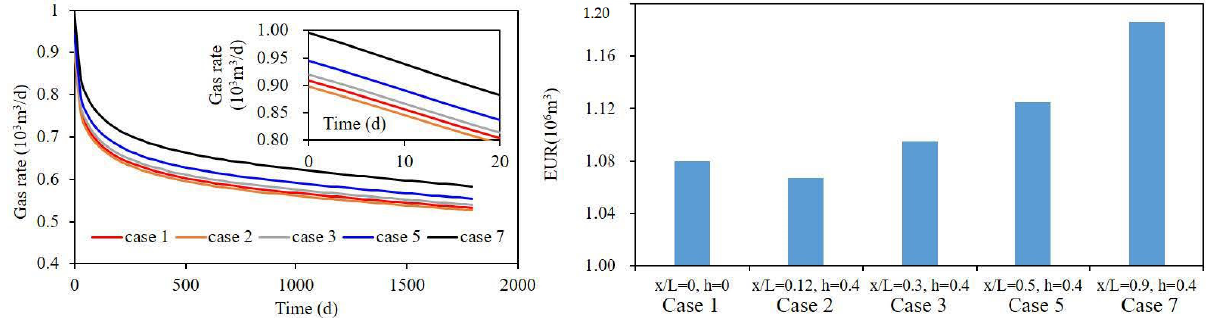
Figure 10. Effect of imbibition length on gas well production when the thickness of the retained water film is constant, the subfigure is the magnification of the intersection with the ordinate.